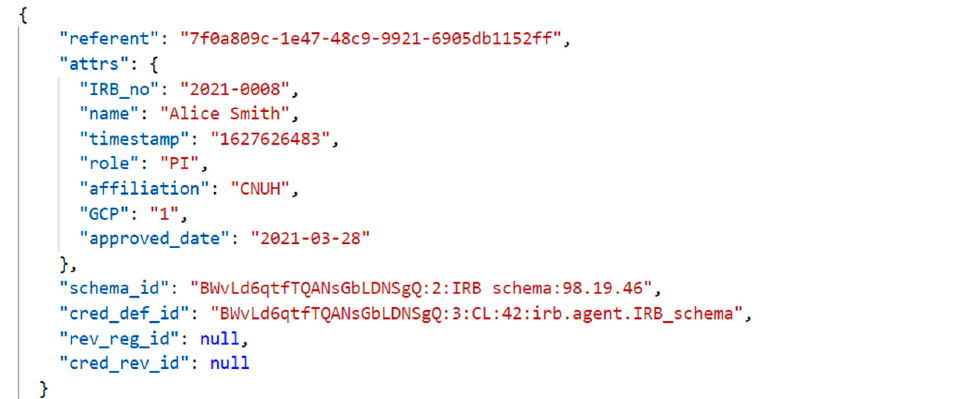
Figure 12. Researcher VC offered by the IRB upon registration.